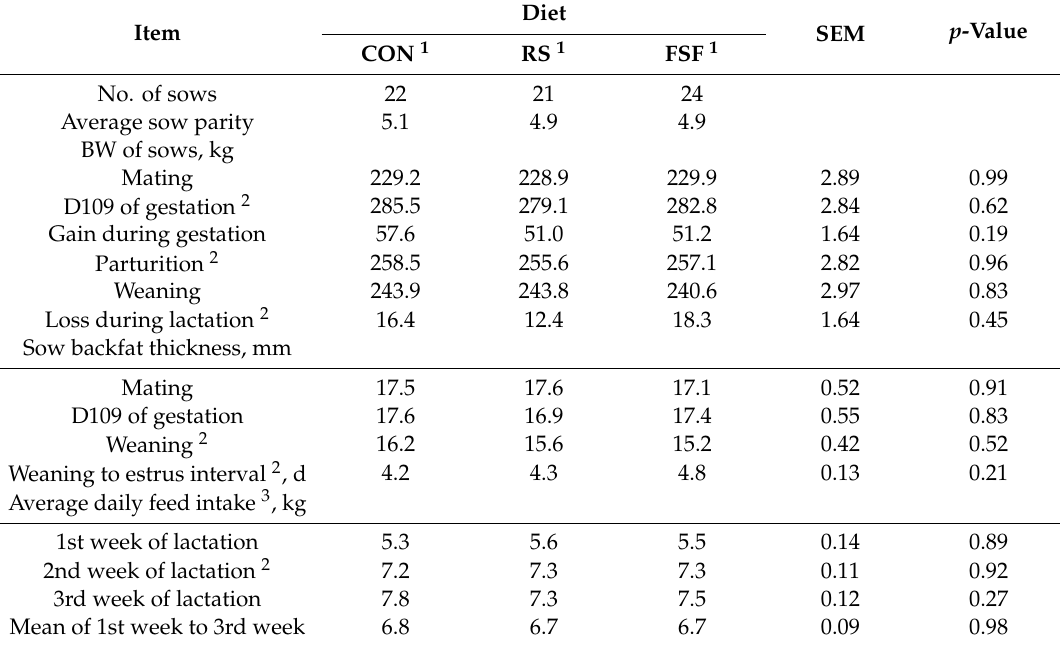
Table 3. E ff ect of inclusion of resistant starch (RS) or fermented soybean fiber (FSF) in gestation diet on body weight, backfat thickness, weaning to estrus interval and feed intake during lactation of sows. Diet Item SEM p -Value CON 1 RS 1 FSF